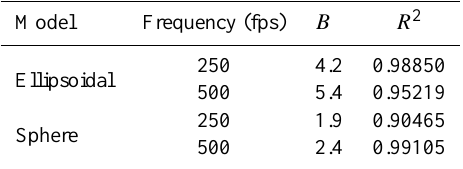
Table 1. The frequency combined mean slope for the ellipsoidal model yields a systematic overestimation of 4.8 ± 0.6 while the sphere yields 2.2 ± 0.3.